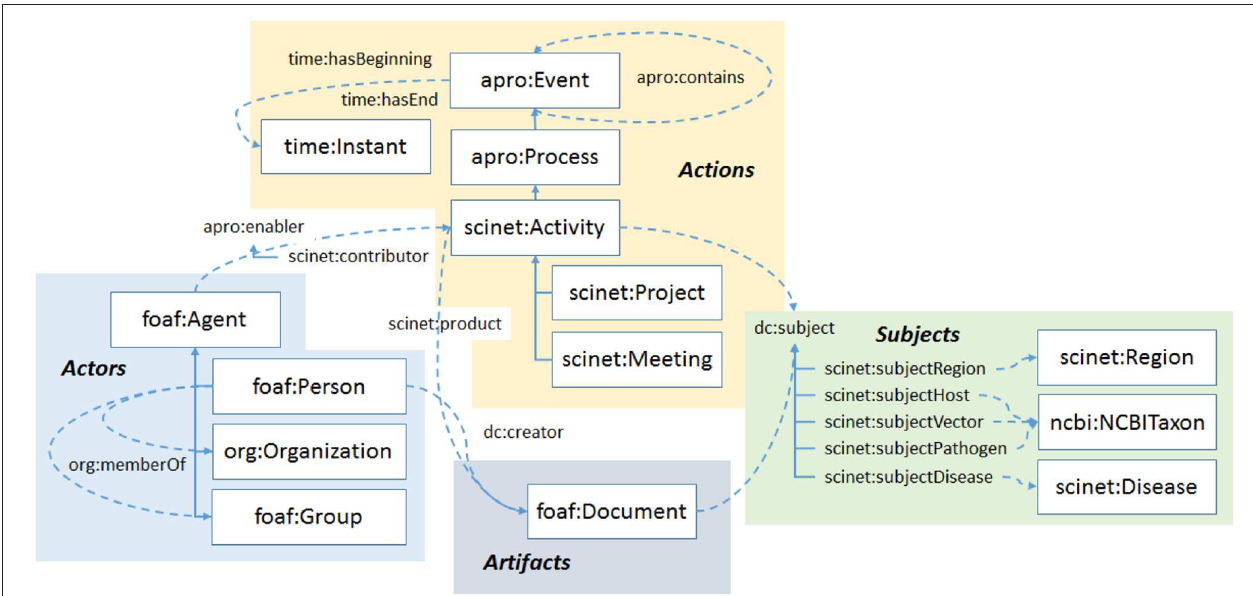
FIGURE 2 | An outline of the SCINET ontology. The ontology brings together several types of entities familiar in workflow analysis such as actors, actions, and artifacts. Each of these can be linked to particular subjects.